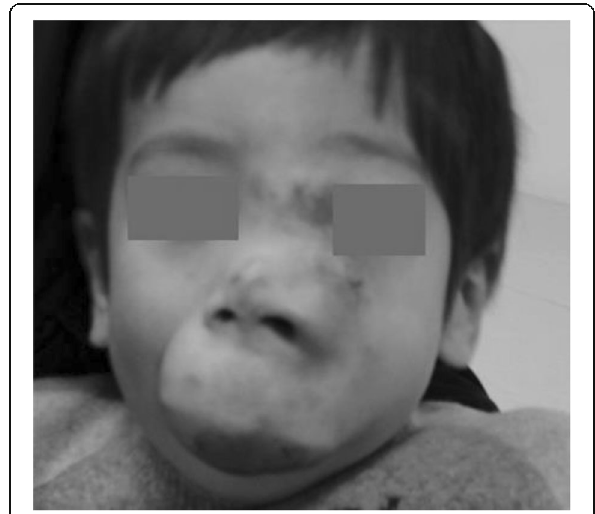
Fig. 1 A 13-month-old infant weighing 8.3 kg, with a height of 72.3 cm. A large vascular malformation occupied his upper lip to his left face, and a swollen upper lip covered the lower